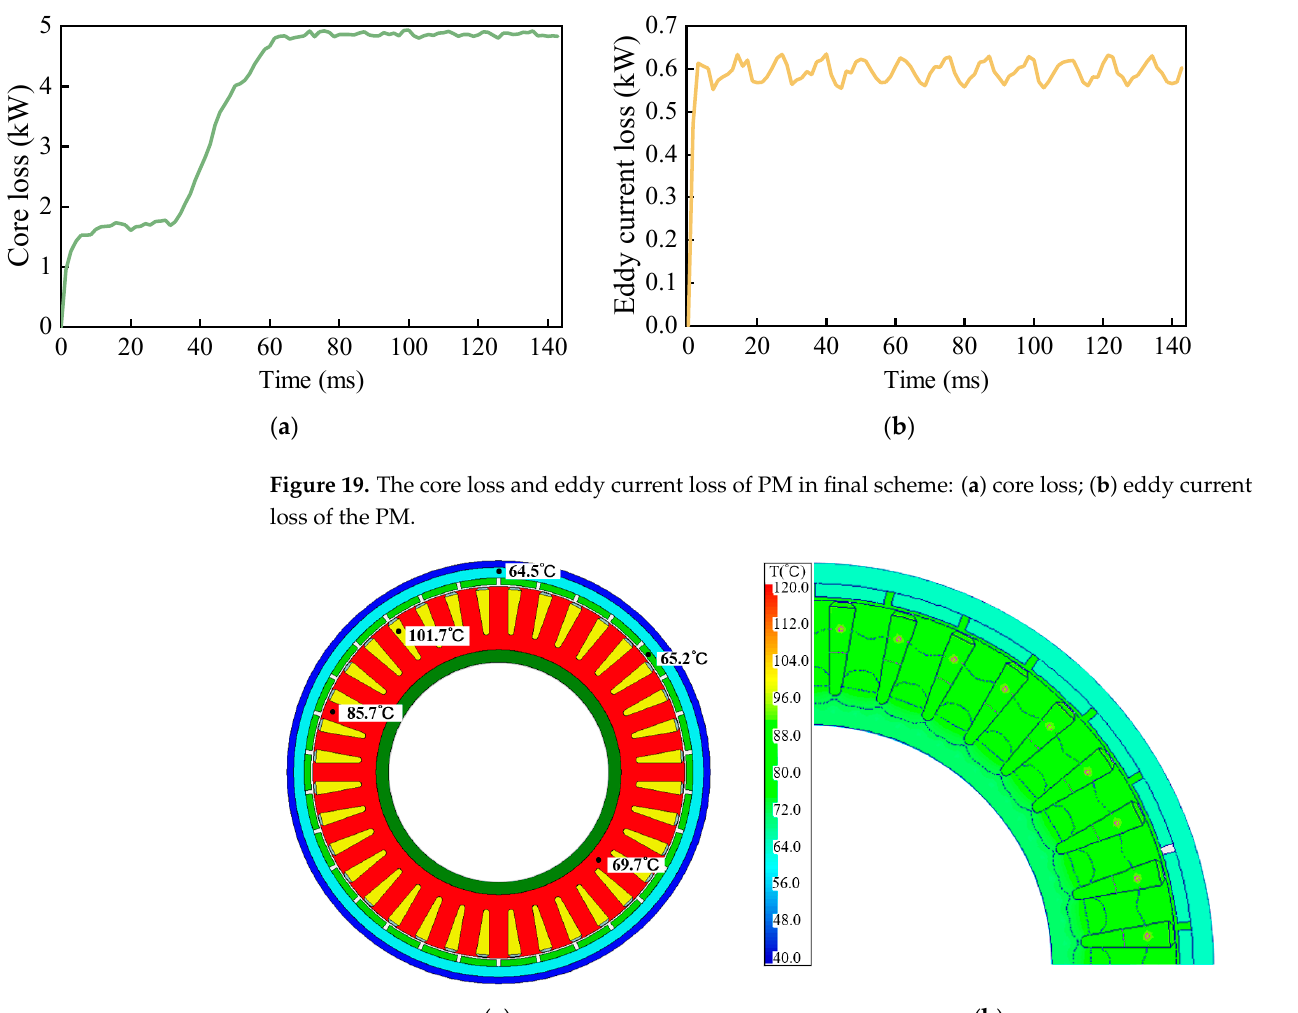
Figure 20. Whole and partial temperature distribution of final scheme: ( a ) whole temperature dis- tribution; ( b ) partial temperature distribution.